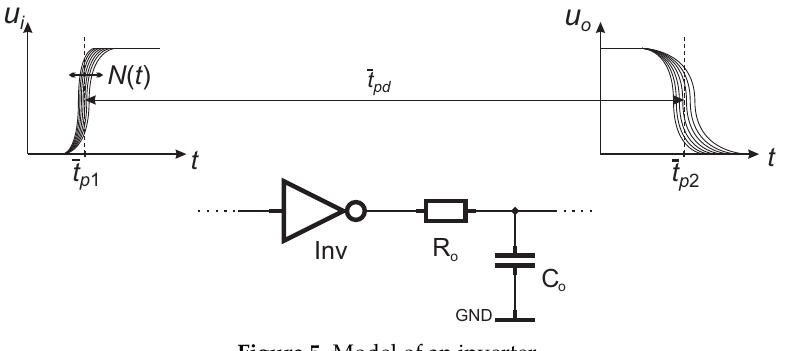
Figure 5. Model of an